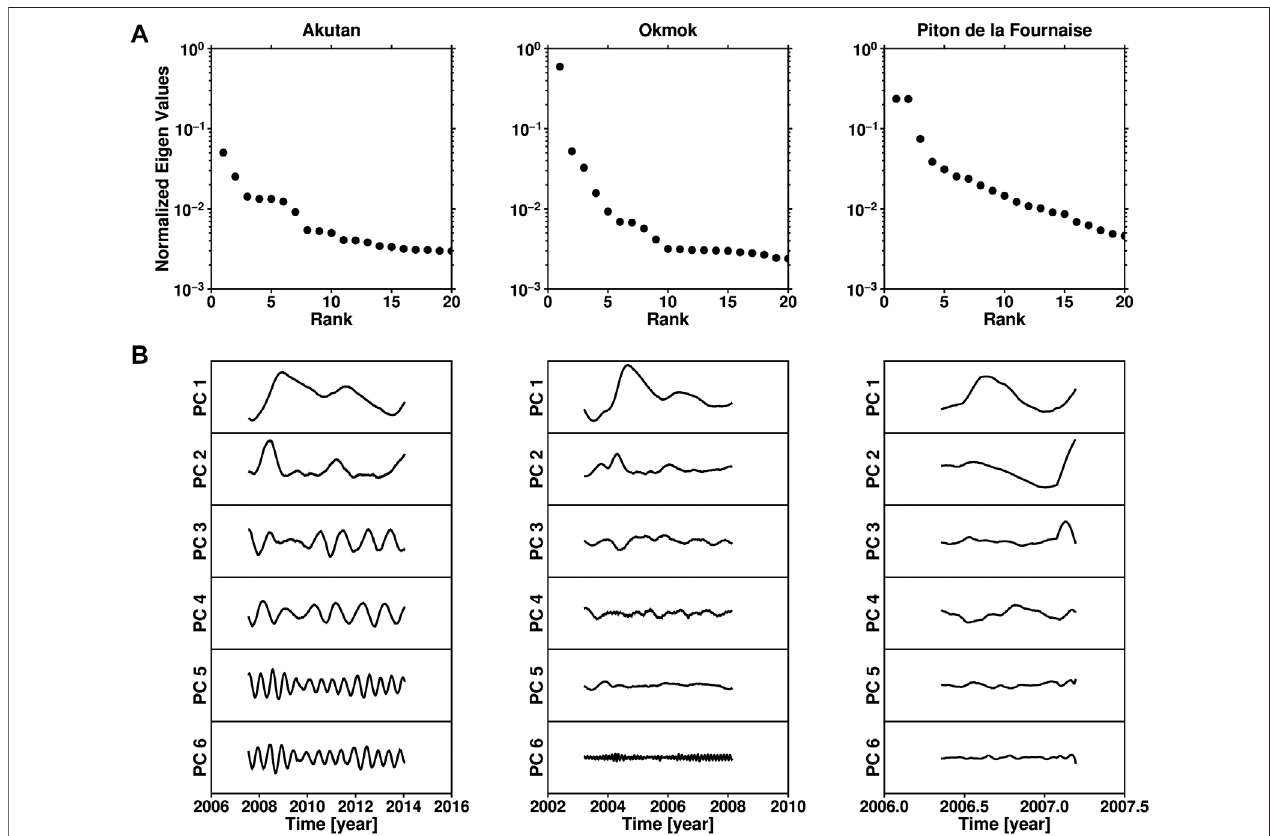
FIGURE3| M-SSAanalysisapplied tothetimeseries recordedatAkutan,OkmokandPitondelaFournaise(PdF).The (A) showthenormalized eigenvalues ofthe GPS position time series. (B) show the 6 leading PCs resulting from the M-SSA analysis applied to these three volcanoes.